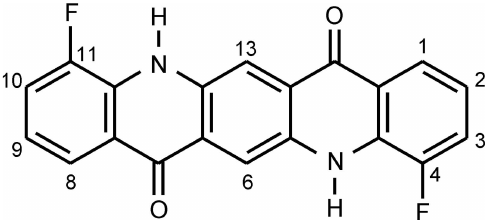
Figure 1 Structural sketch of 4,11-difluoroquinacridone (DFQ), with numbering scheme. (In the parent compound quinacridone, both F atoms are replaced by H